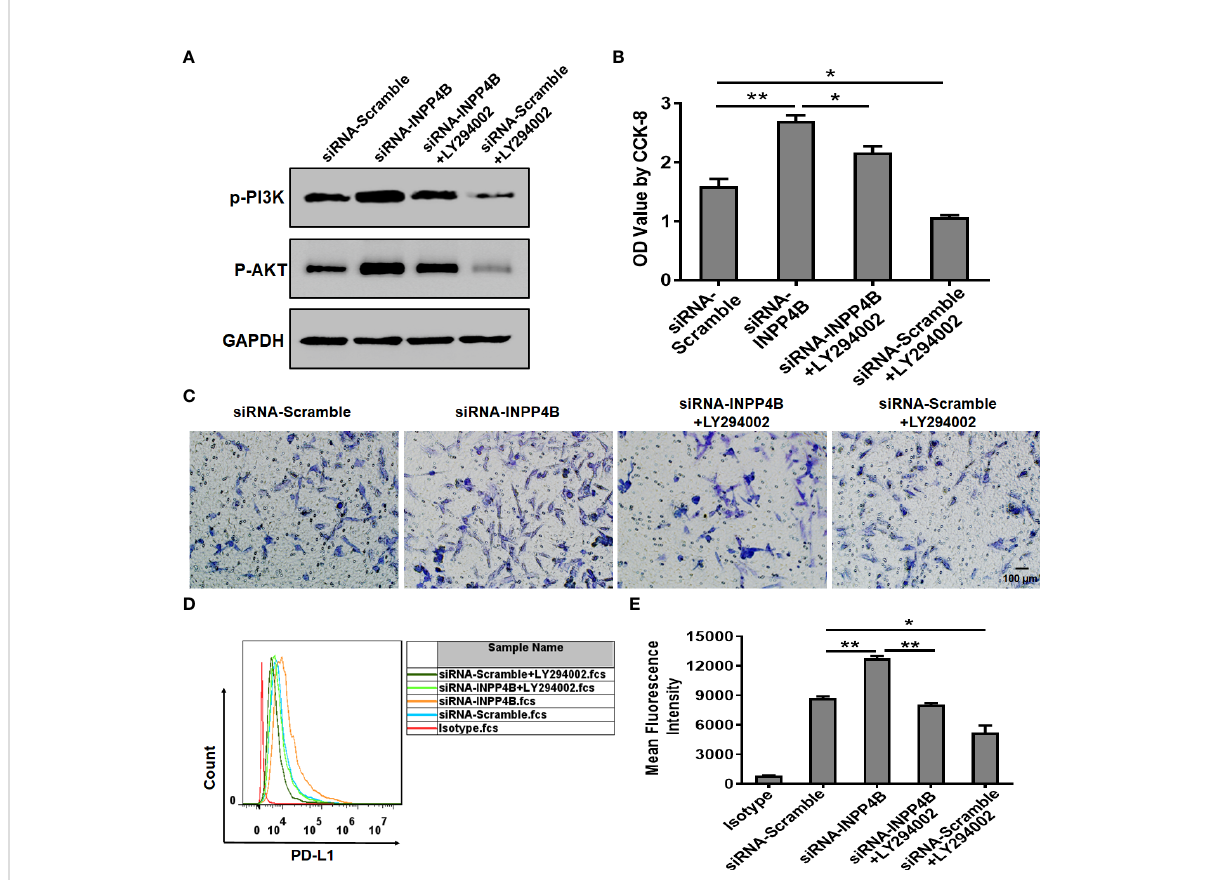
FIGURE 7 INPP4B knockdown promotes glioma cell proliferation, migration, and PD-L1 expression by up-regulating PI3K/AKT signaling. Effect of the PI3K/ AKT inhibitor LY294002 on proliferation, migration, and PD-L1 expression in INPP4B-knockdown U87 cells. (A) p-PI3K and p-AKT protein expression; (B) proliferation assessed by CCK-8 assay; (C) migratory properties assessed by transwell migration assay; (D, E) PD-L1 expression assessed by fl ow cytometry. Values represent the means ± SD (n = 3); * p < 0.05, ** p <